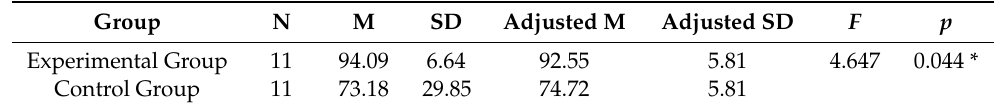
Table 2. The ANCOVA result of the learning achievement for the two groups. Group N M SD Adjusted M Experimental Group